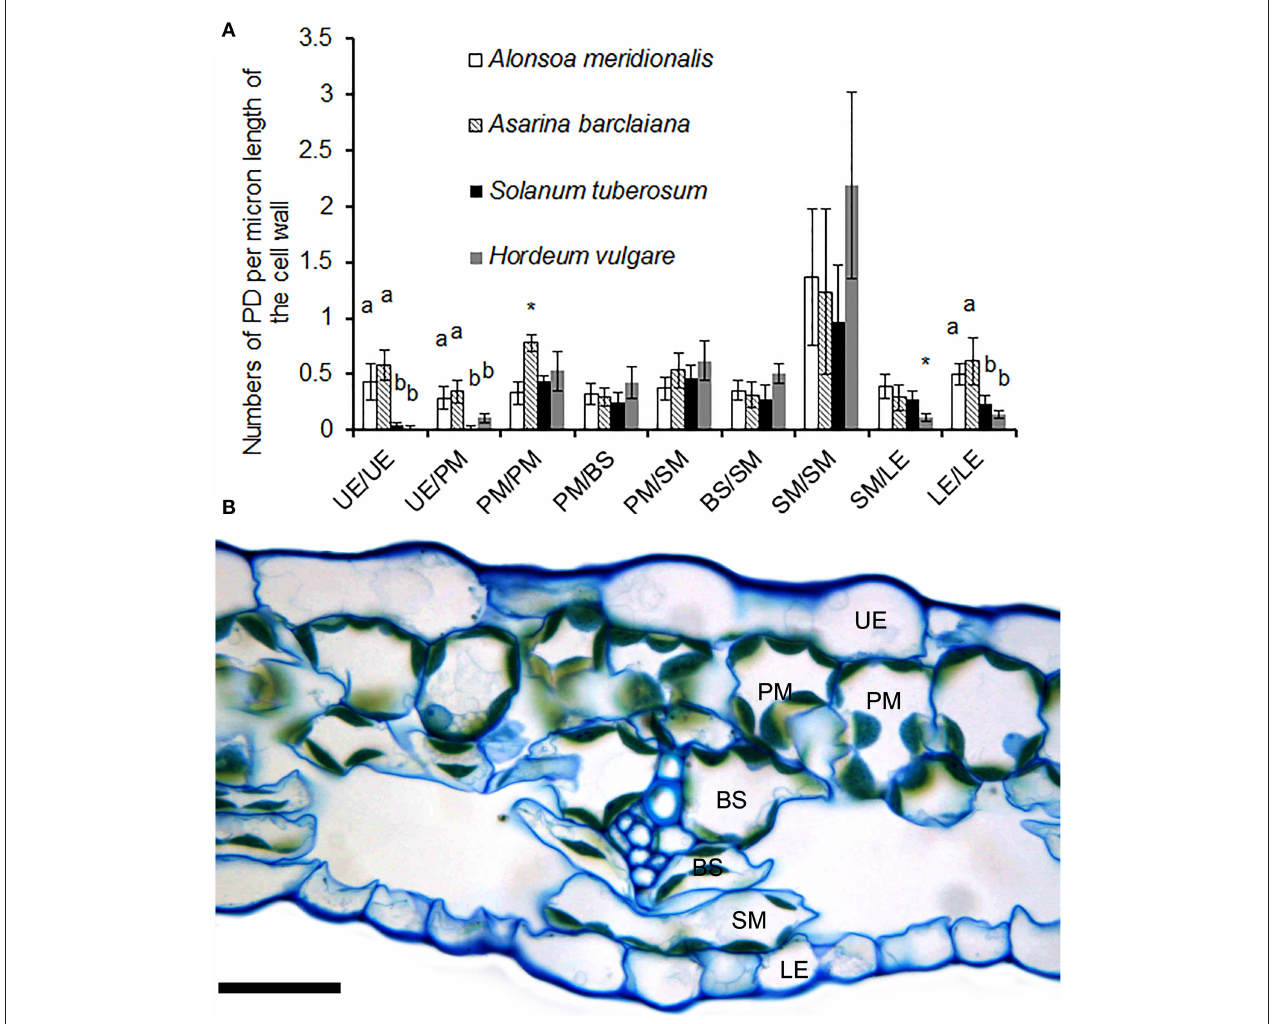
FIGURE 3 | (A) Counts of immunolabeled PD/pitfields between different cells/tissues per µ m length of cell wall as found on transverse sections through the cell wall in leaves of A. meridionalis , A. barclaiana , potato ( Solanum tuberosum ), and barley ( Hordeum vulgare ). Data represent average values for 10 cell borders ± SD. UE, upper epidermis; PM, palisade mesophyll; BS, bundle sheath; SM, spongy mesophyll; LE, lower epidermis. Different letters indicate significant differences between species for a boundary type at least at the level of p < 0.01, * stands for significant differences at the level of p < 0.05, according to one-way ANOVA with post hoc Tukey’s test. (B) Cross-section of a leaf of A. barclaiana showing the position of the analyzed cell types within the leaf lamina. Size bar: 20 µ